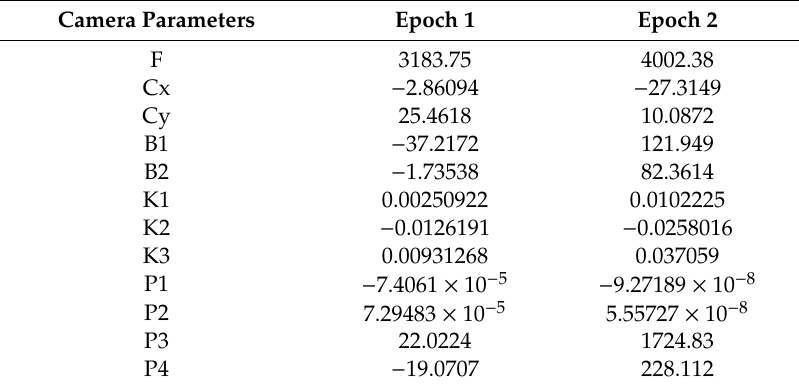
Table 3. Camera parameters for both epochs of flight.